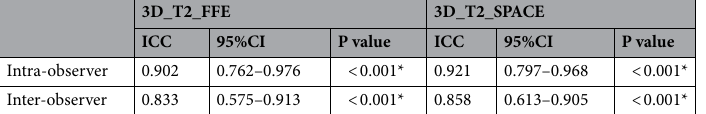
Table 4. Intra- and inter-observer variability of the data analysis in the two MRI sequences. 95% CI, 95% confidence interval; FFE, fast field echo; SPACE, sampling perfection with application-optimized contrast using different flip angle evolutions; MRI, magnetic resonance imaging. *P <